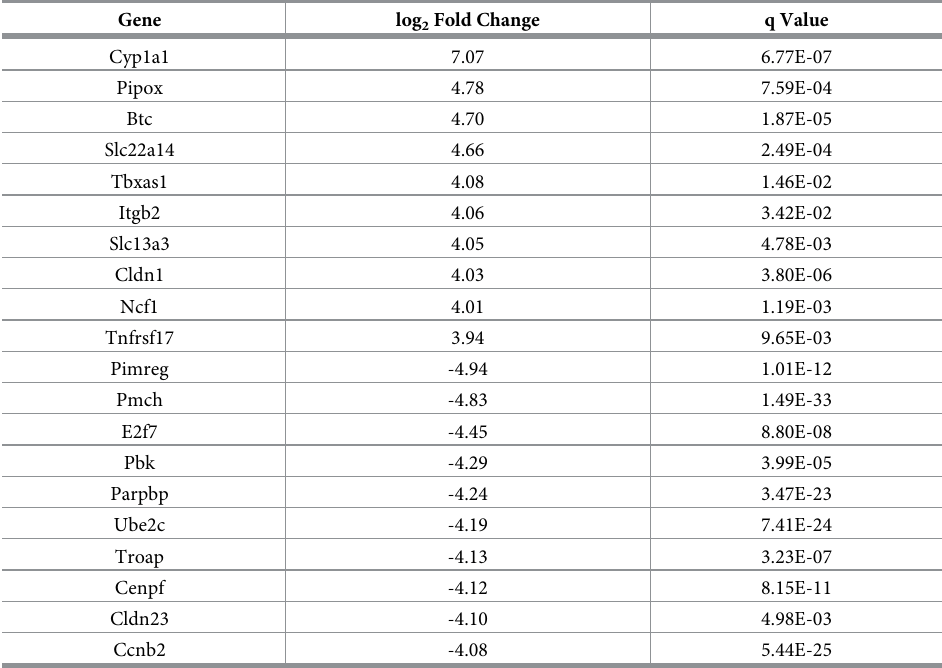
Table 1. Most affected gene